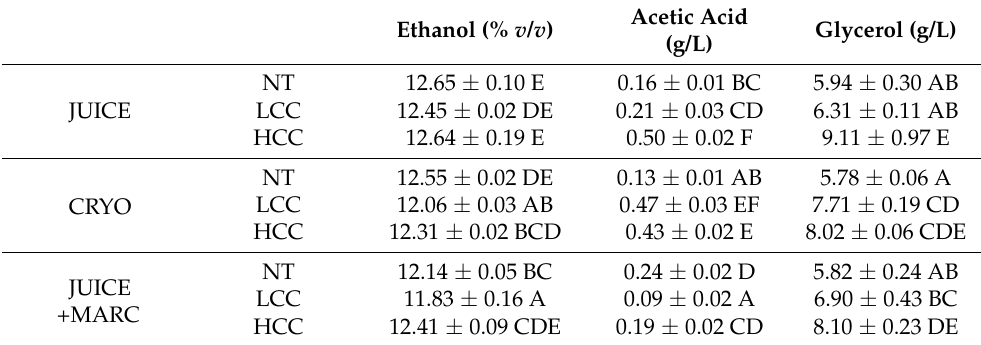
Table 4. Glycerol, acetic acid and ethanol concentrations at the end of